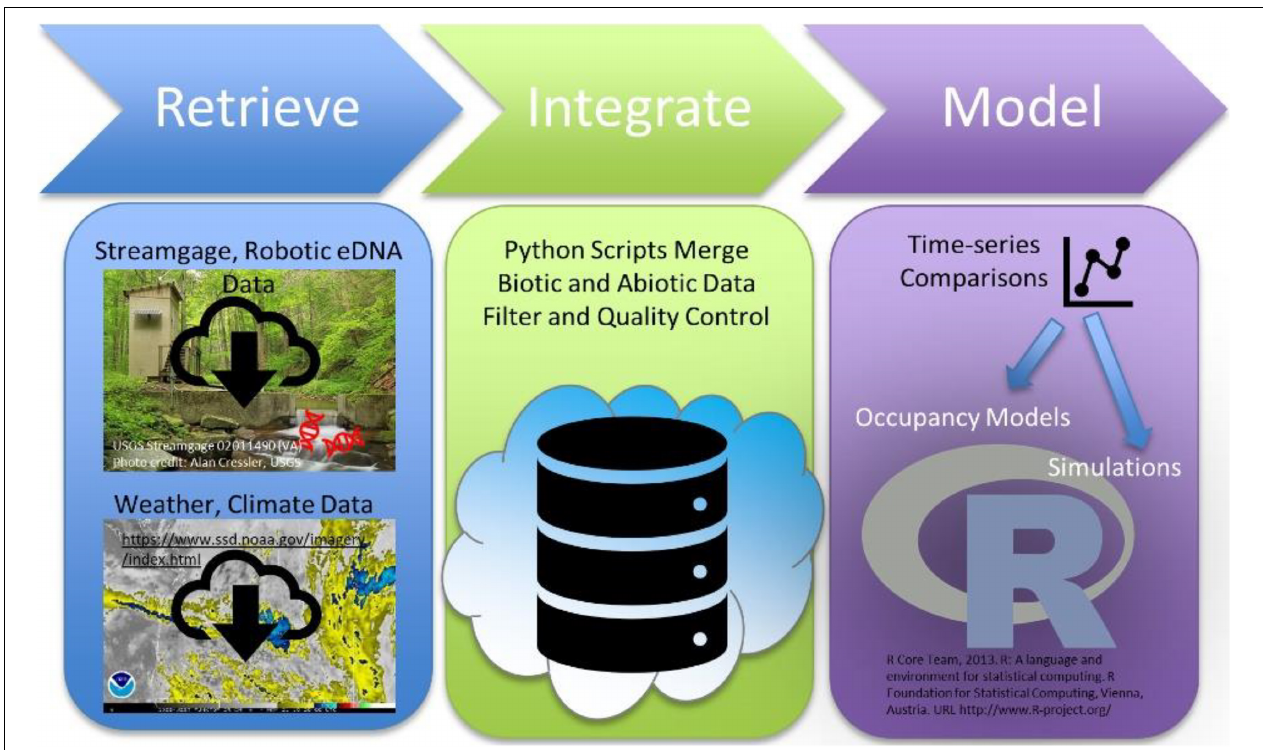
FIGURE 1 | Schematic of the data science workflow applied to our two eDNA case